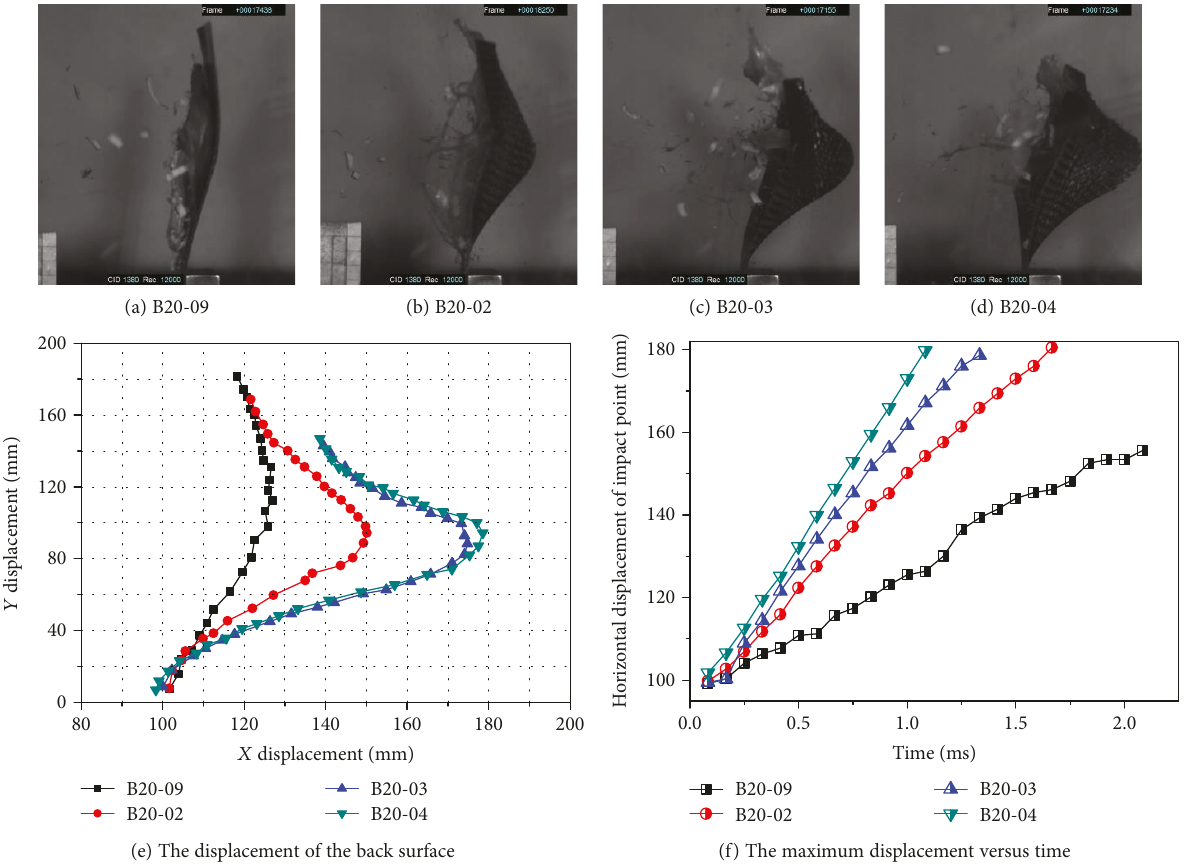
Figure 5: Maximum deformation of 20 ° braiding composite target under di ff erent impact